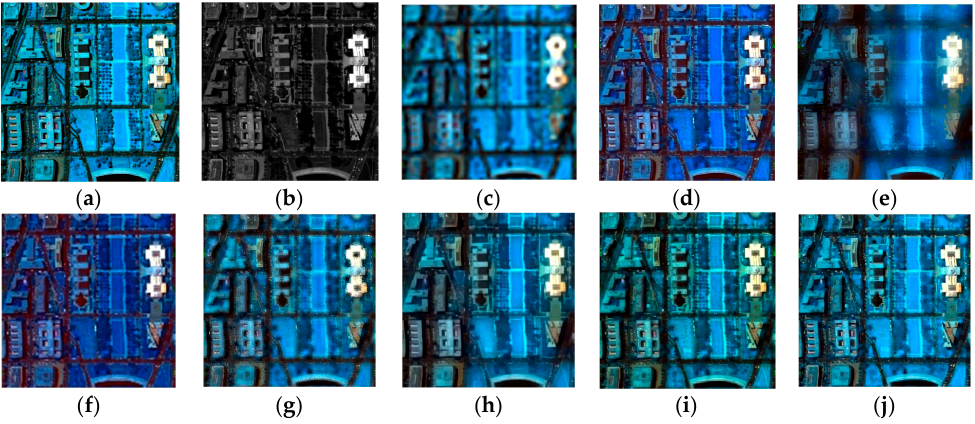
Figure 9. Fusion results obtained by each method for Washington DC dataset. ( a ) Reference HS image; ( b ) Simulated PAN image; ( c ) Interpolated HS image; ( d ) PCA; ( e ) GFPCA; ( f ) BT; ( g ) CNMF; ( h ) BSF; ( i ) MGH; ( j )